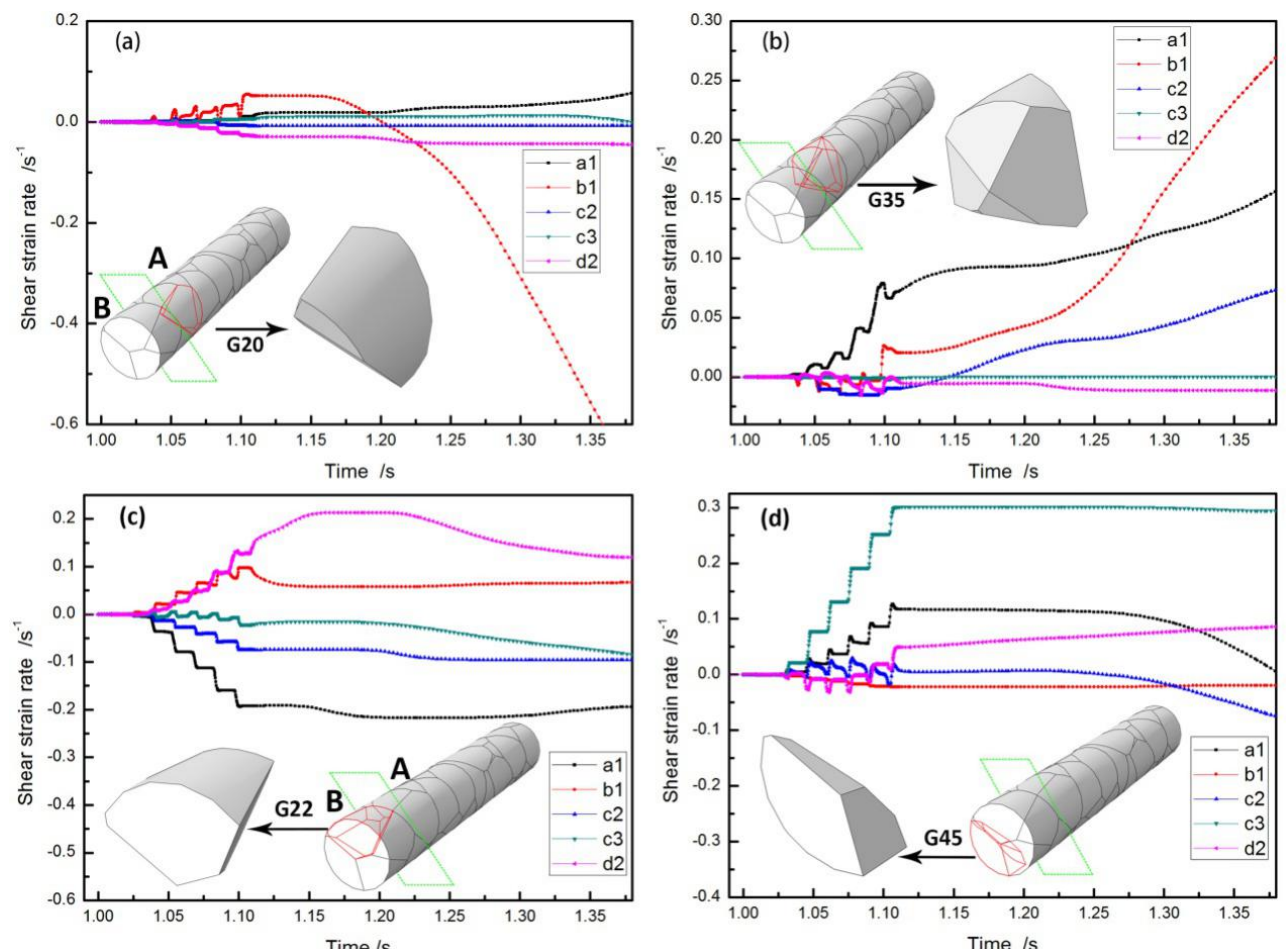
Figure 14. Shear strain rate of the slip system: ( a ) G20; ( b ) G35; ( c ) G22; ( d ) G45.